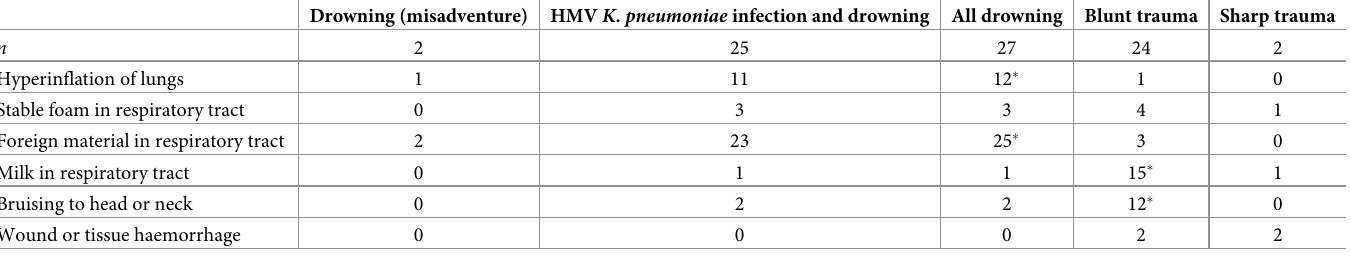
Table 6. Gross necropsy findings for trauma/asphyxiation cases in New Zealand sea lion ( Phocarctos hookeri ) pups at Sandy Bay, Enderby Island. Pups with a com- pound diagnosis of hypermucoviscous K . pneumoniae and drowning are included for